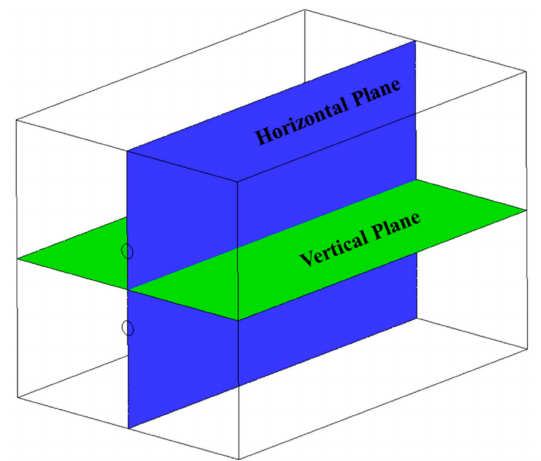
Figure 6. Location of planes used for the jet impingement